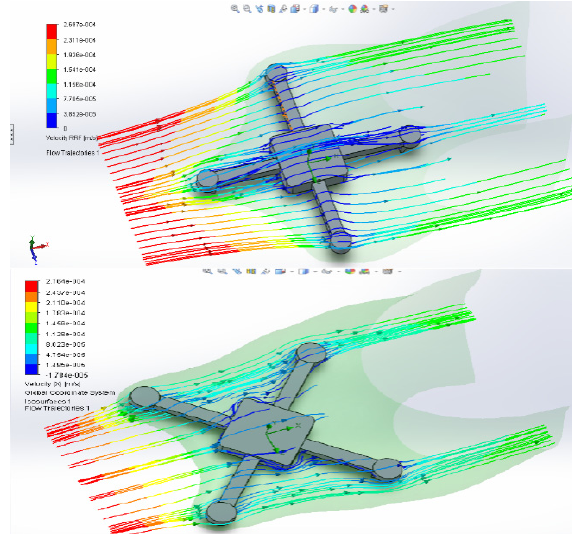
Figure 7. plus and cross quadcopter flow trajectories Going back to Equation 2 and substituting each term with its corresponding will